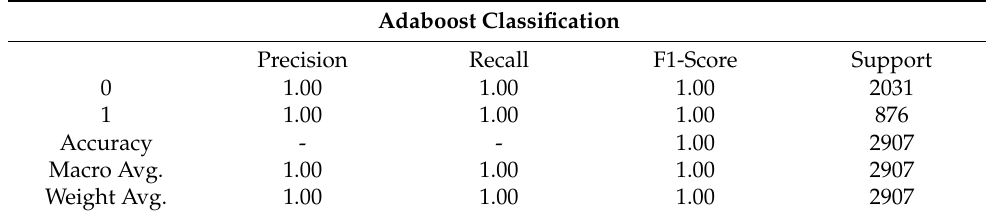
Table 3. Adaboost classification report.